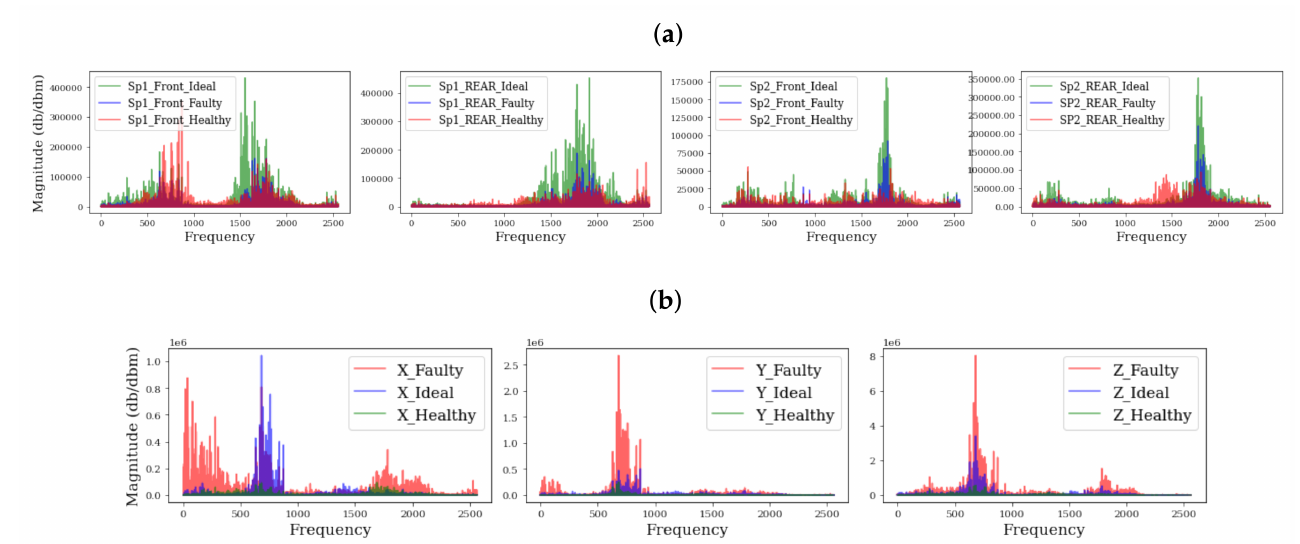
Figure 6. Spectral comparison of different grinder health states. ( a ) Spindle, ( b ) frame. It is observed from Figure 5a–d that the regrinding spindles/wheels’ responses are